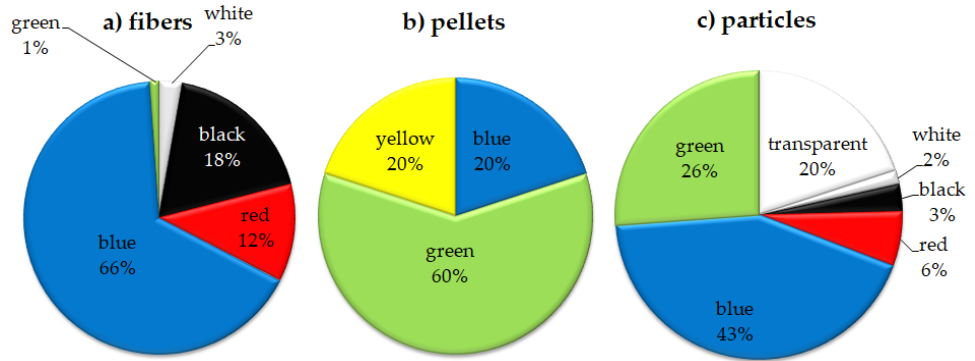
Figure 6. Percentage contribution of dominating colors of MPs for fibers ( a ), pellets ( b ), and particles ( c )in the southern Baltic Sea fish.